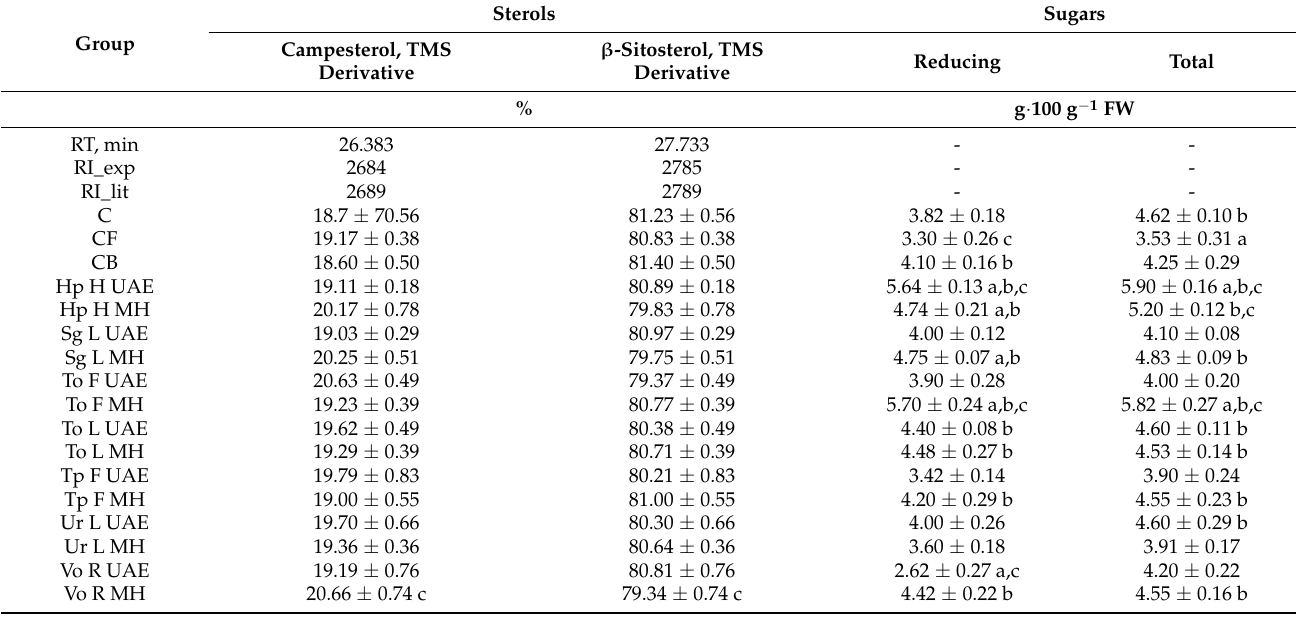
Table 6. Effect of the foliar application of the botanical extracts on the sterols composition (the amount of a single component calculated as a percentage (%) of the whole GC-MS chromatogram area) and the sugar content in cabbage head after harvest ( n = 3, mean ±